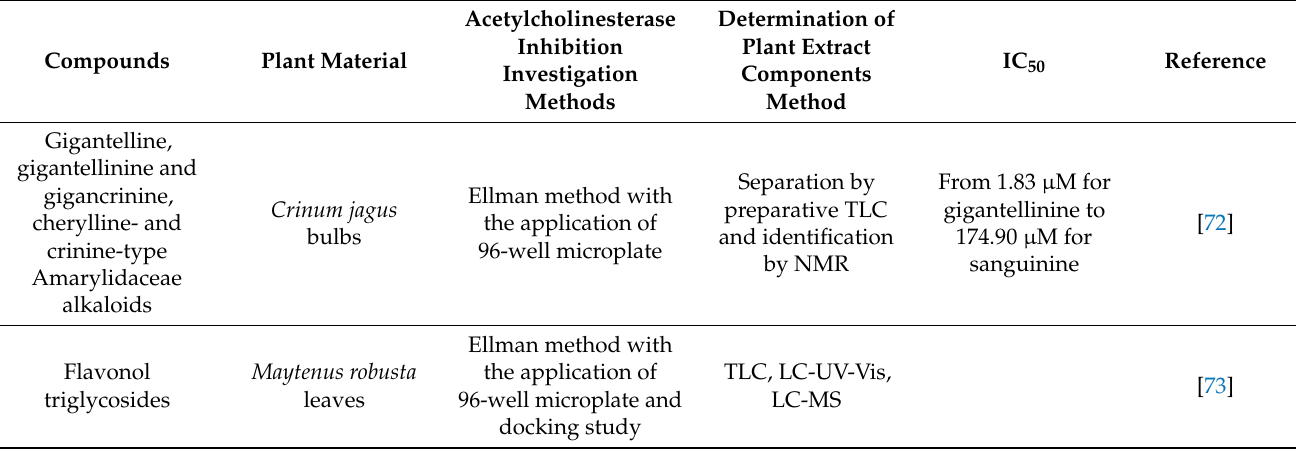
Table 1. Acetylcholinesterase inhibition by plant